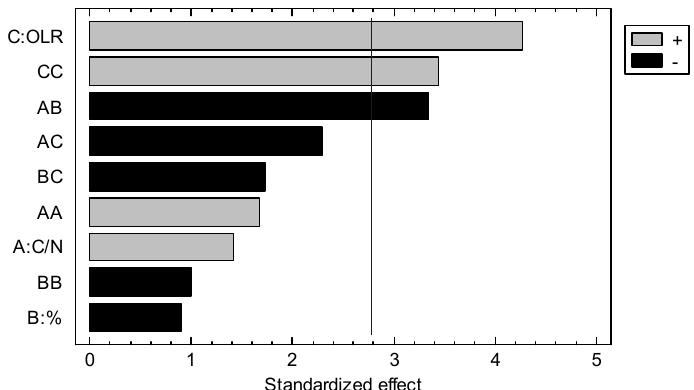
Figure 4. Pareto chart analysis for daily biogas production estimations.